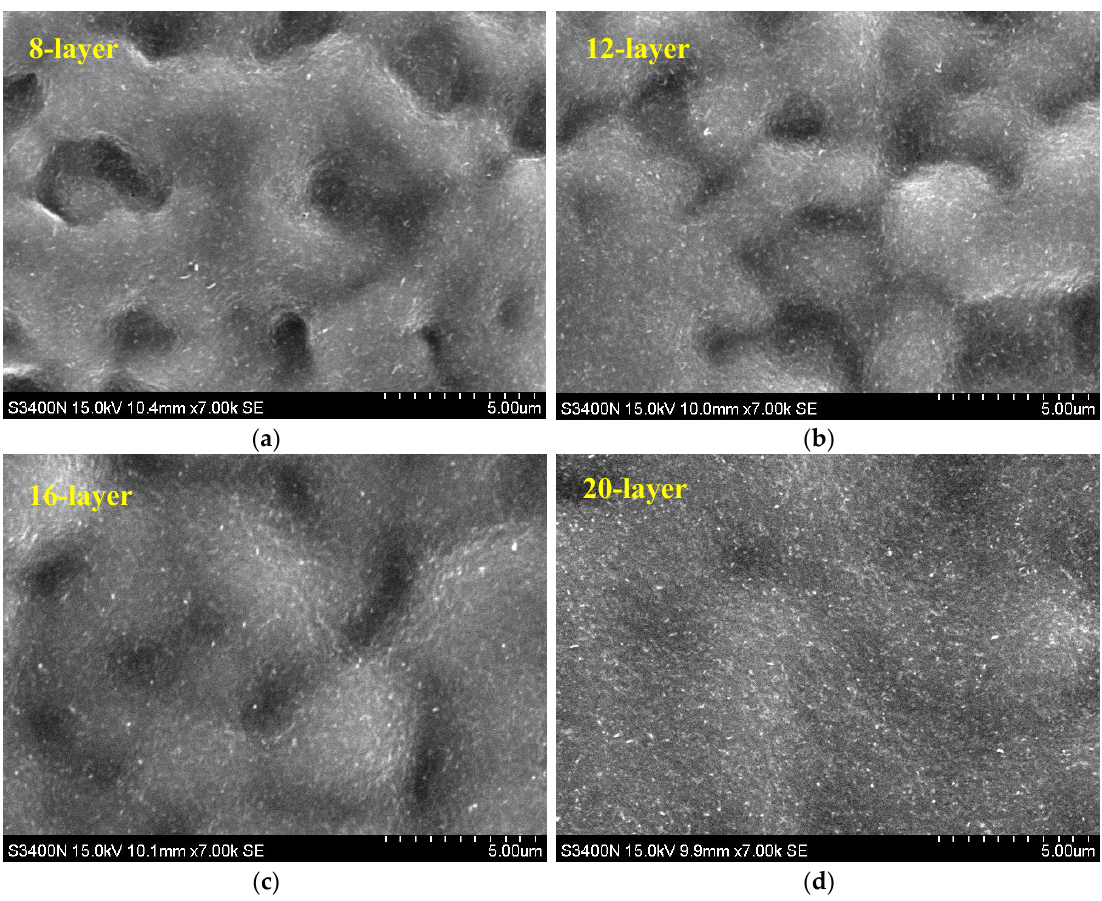
Figure 7. Surface morphologies of CNT films at magnifications of 7000× from ( a ) 8-layer printing; ( b ) 12-layer printing; ( c ) 16-layer printing; ( d ) 20-layer printing.